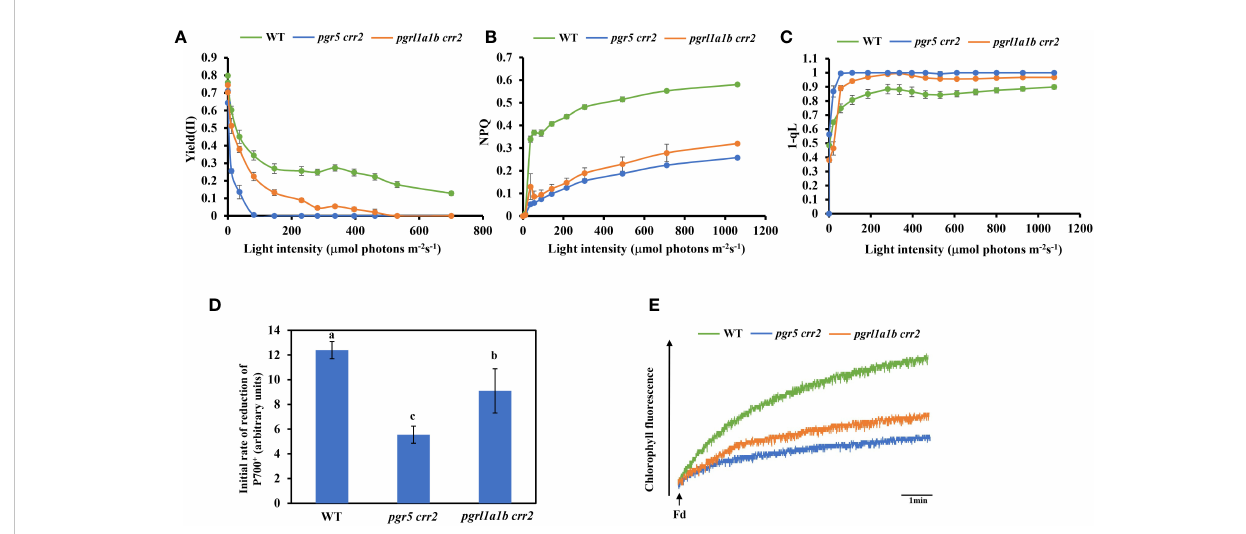
FIGURE 3 Comparison of chlorophyll fl uorescence parameters and CET activity among CET mutants and wild type (WT) grown under high light conditions. (A) Light curve of the quantum yield of the PSII photochemistry [Yield (II)]. (B) Light curve of non-photochemical quenching (NPQ). (C) Light curve of redox state of Q A calculated as 1 − qL. (D) The initial reduction rate of P700 + after far-red light. (E) Increase in chlorophyll fl uorescence induced by the addition of NADPH (0.25 mM) and Fd (5 mM) to osmotically ruptured chloroplasts (20 m g Chl ml − 1 ) under the illumination of weak measuring light (1.0 m mol photons m − 2 s − 1 ) in the WT and CET mutants. Values are means ± SE of fi ve independent measurements. Signi fi cant differences ( p < 0.05) are labeled with different letters on the column. The least difference method ( LSD method) was used for the difference signi fi cance test and multiple ratio comparison. The plants used for these measurements were cultured on agar plates at 60 m mol m − 2 s − 1 at 22°C for 10 days and transferred to the soil at a light intensity of 120 m mol m − 2 s − 1 at 22°C for 18 days. Values are means ± SE (n = 5 – 9) offour independent